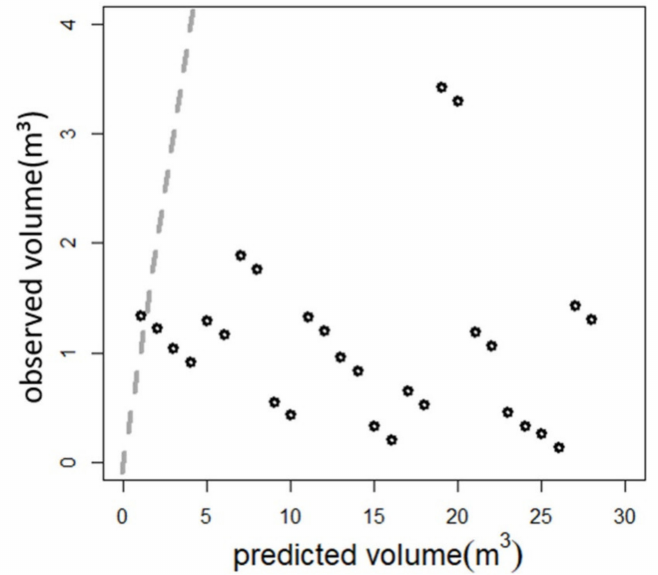
Figure 6. Predicted versus observed volume (m 3 ) for the general mixed-effects model using LAI as the only predictor (marginal R 2 = 0.01). Dashed grey line is the 1:1